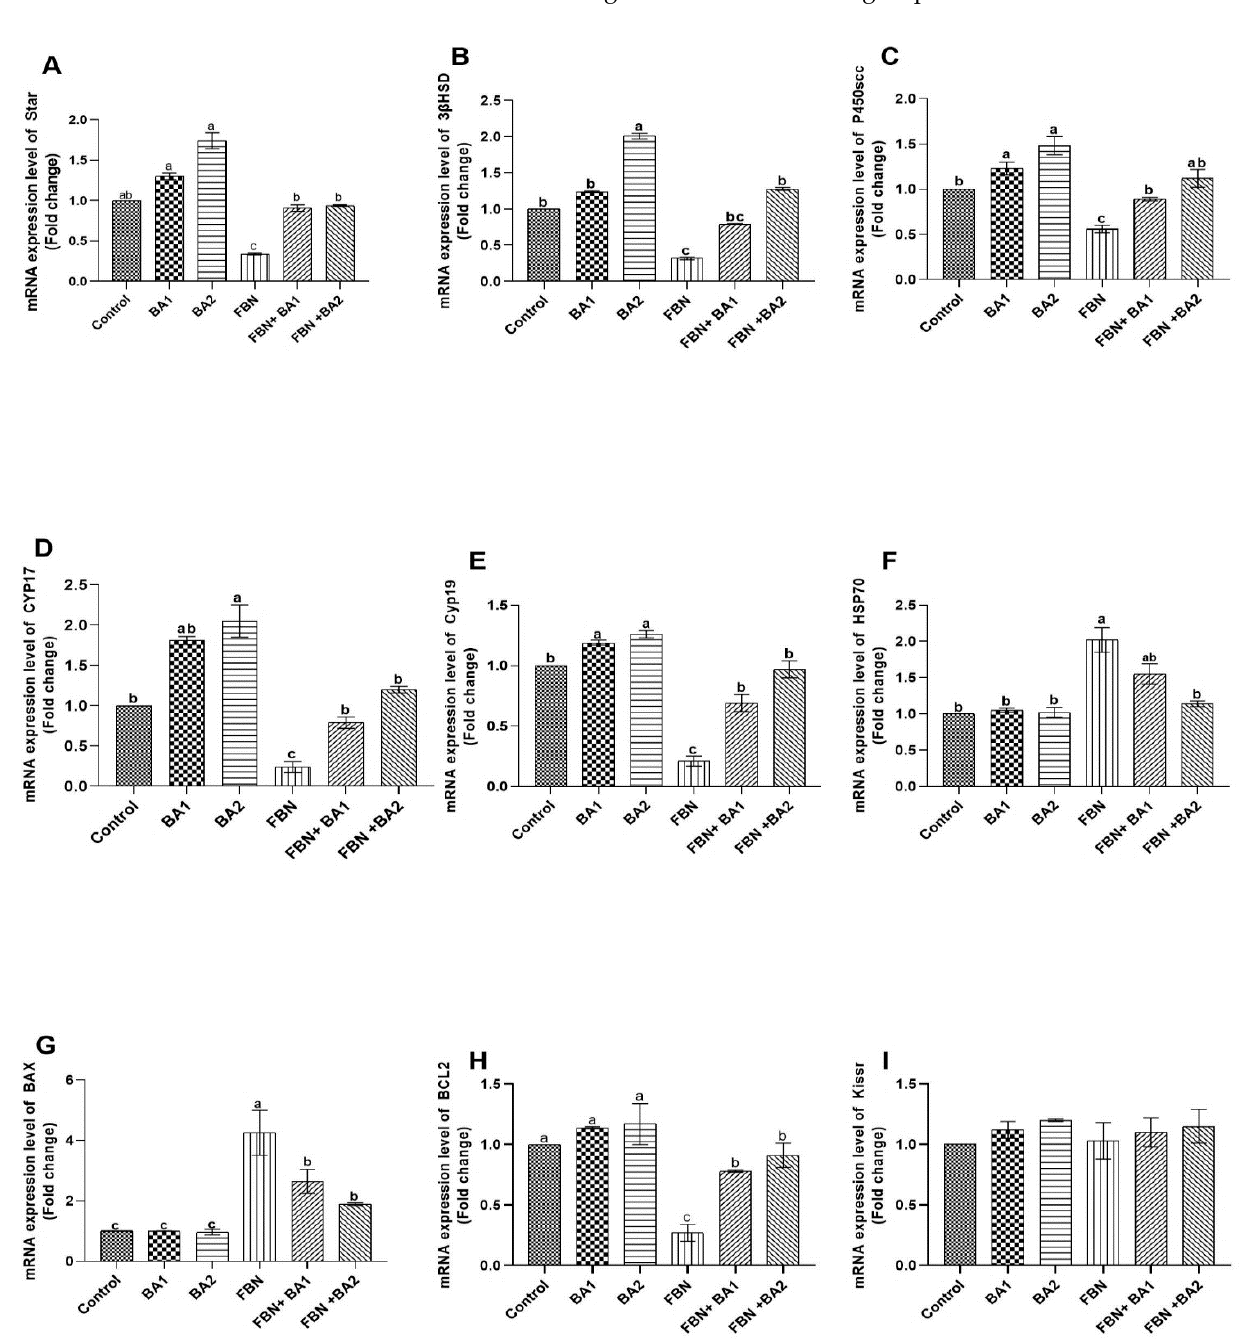
Figure 7. The effect of fipronil (FPN) and co-treatment with boswellic acid (BA) on gene expression of steroidogenic markers genes, apoptotic genes, and heat shock protein gene. STAR ( A ), 3 β -HSD ( B ), P450SCC ( C ), CYP17A1 ( D ), Cyp19 ( E ), HSP70 ( F ), Bax ( G ), Bcl-2 ( H ), and KISS1 ( I ). All values are expressed as mean ± SEM. ( a – c ) Mean values of different letters within the same row are significantly different ( p < 0.05, ANOVA with Duncan’s multiple range test.